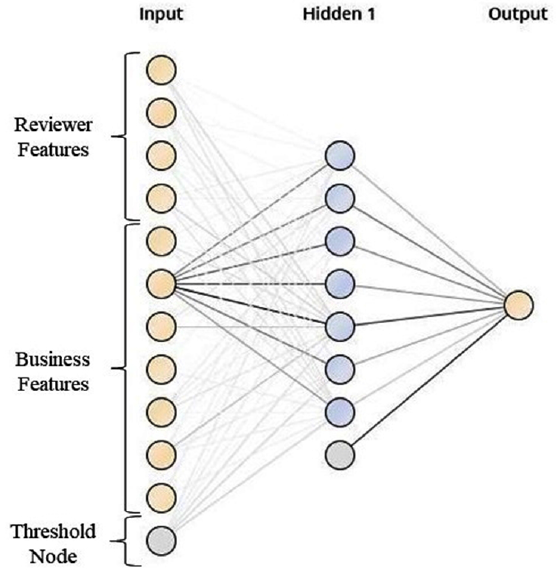
Figure 5. Multilayer neural network for